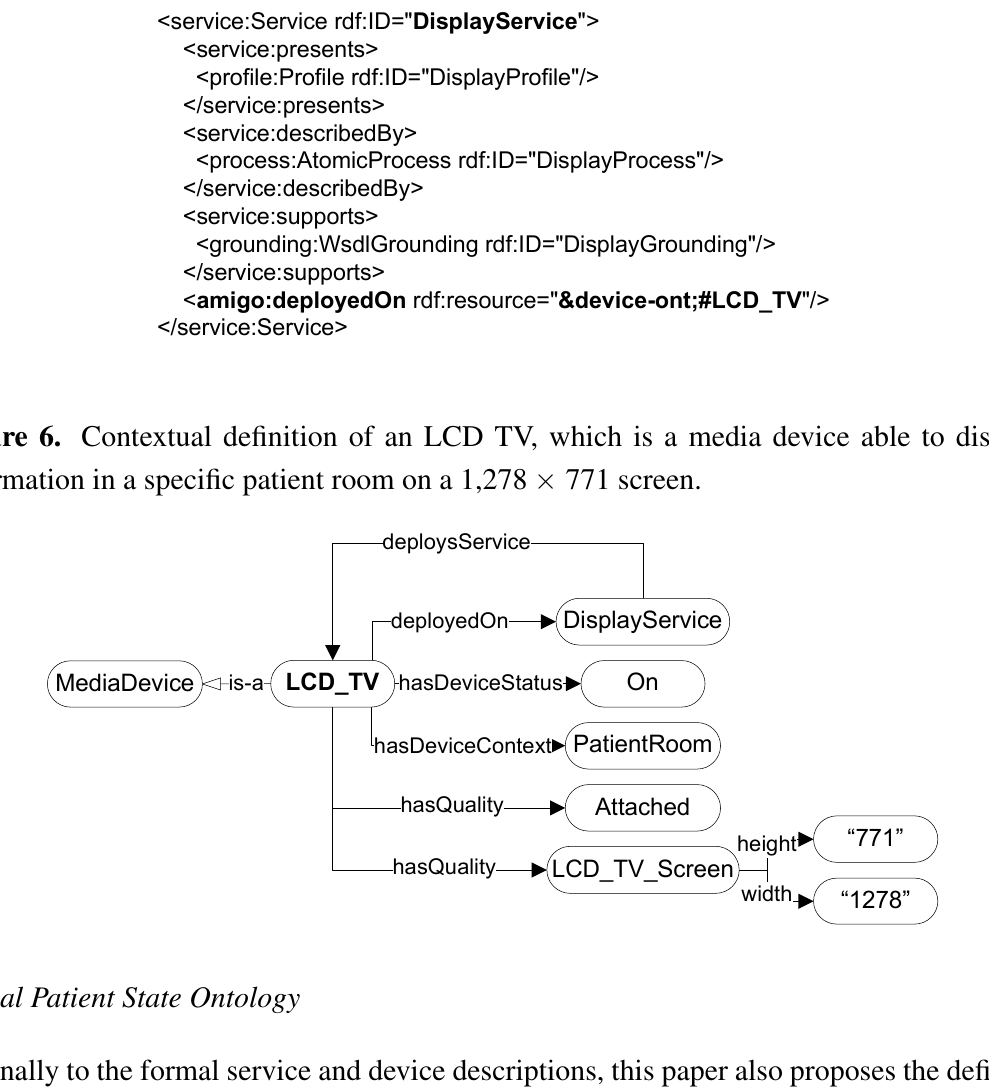
Figure 5. Extension of the standard OWL-Sservice description with the specification of a device on which the service is deployed.